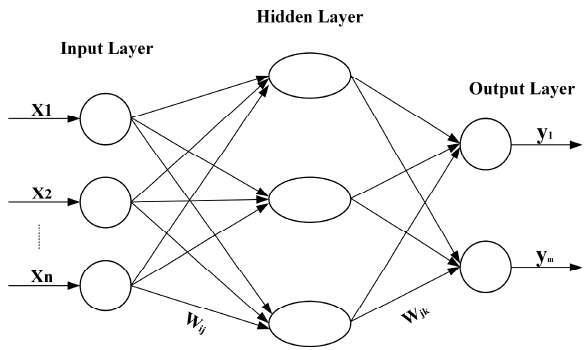
Figure 2. Schematic figures of the back propagation artificial neural network (BP-ANN) method.